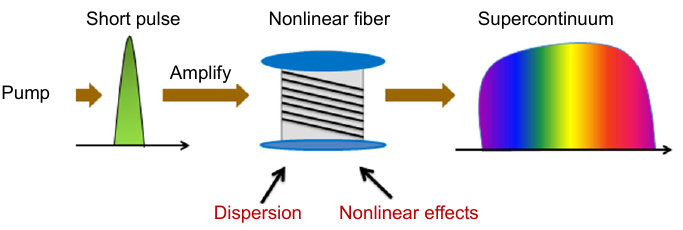
Dispersion Nonlinear Fig. 1 | Schematic diagram of supercontinuum generation.